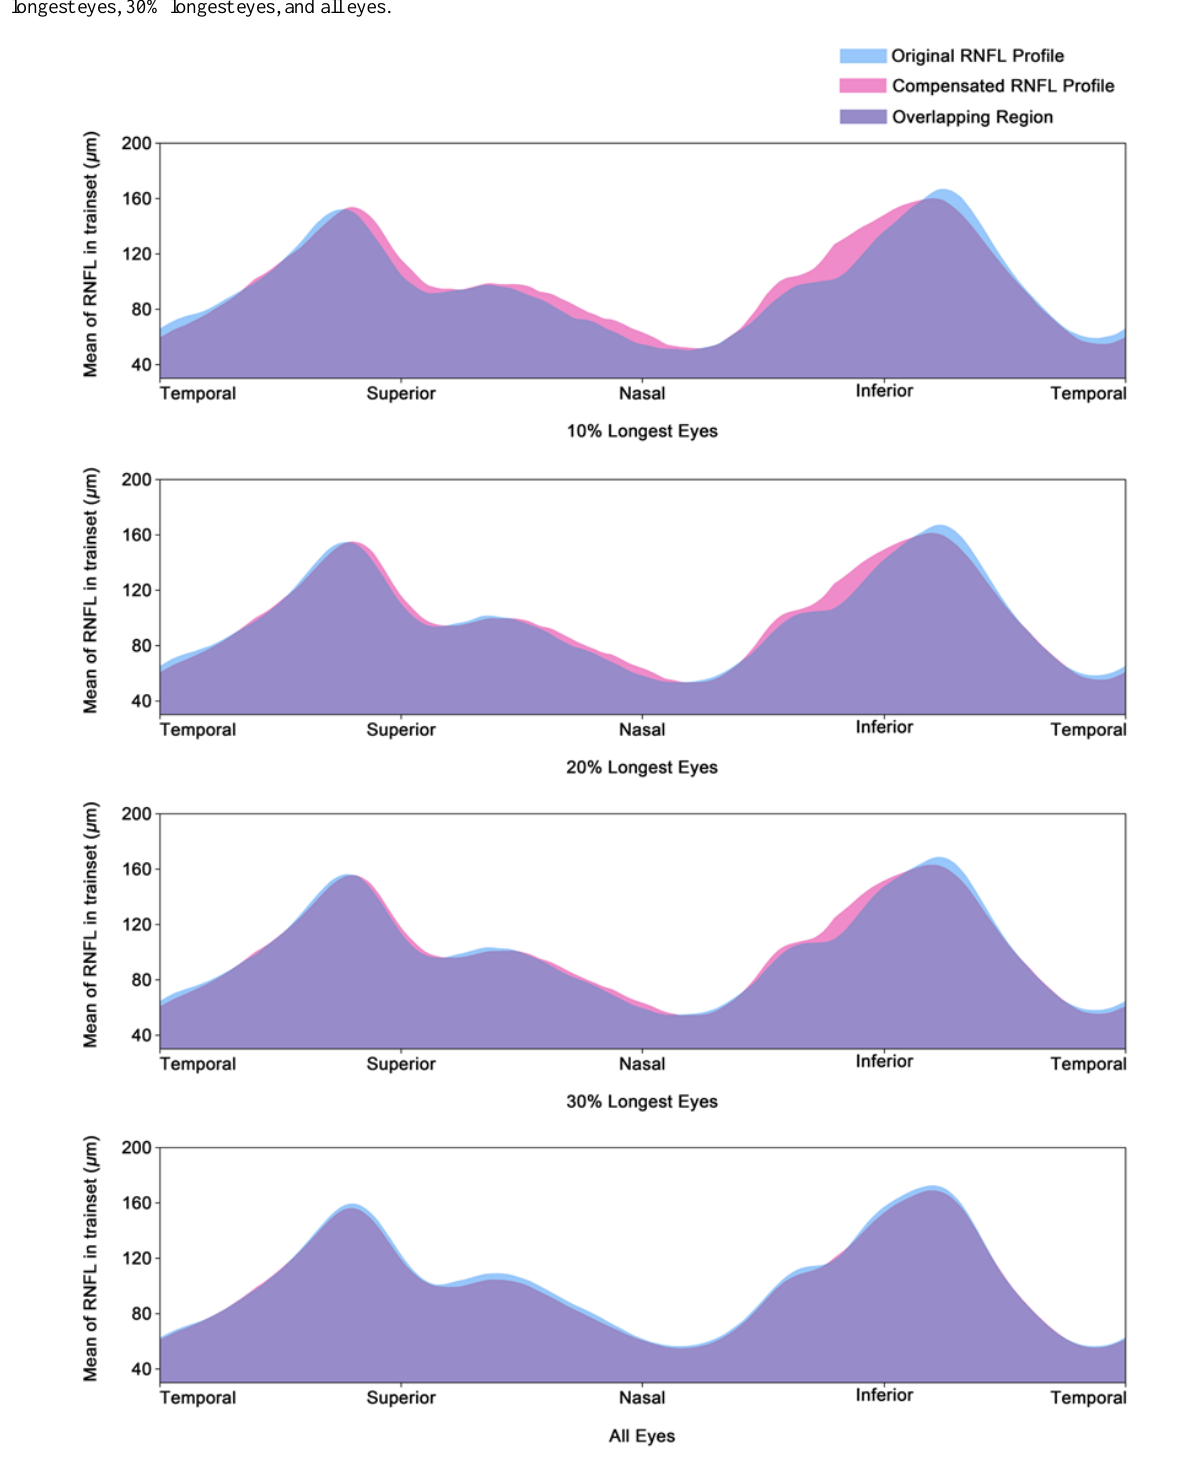
Figure 3. The mean original retinal nerve fiber layer (RNFL) profile (blue) and the mean compensated RNFL profile (pink) of the 10% longest eyes, 20% longest eyes, 30% longest eyes, and all